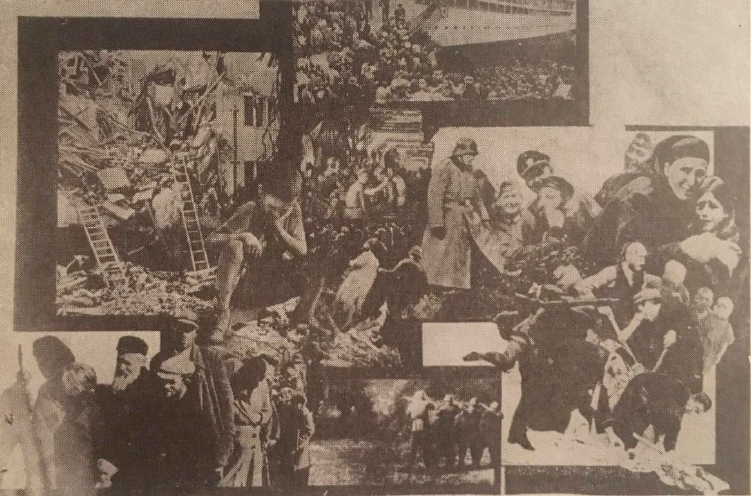
Figure 7. Teresa Ż arnower, In the days of terror (1), photomontage from the book Defense of Warsaw ,